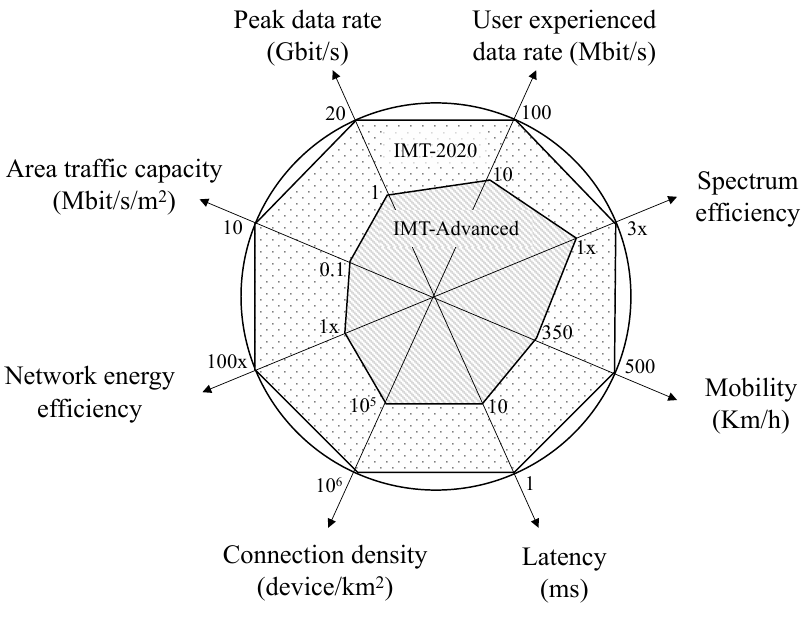
Figure 1. IMT-2020 (5G) vs. IMT-Advanced (4G)